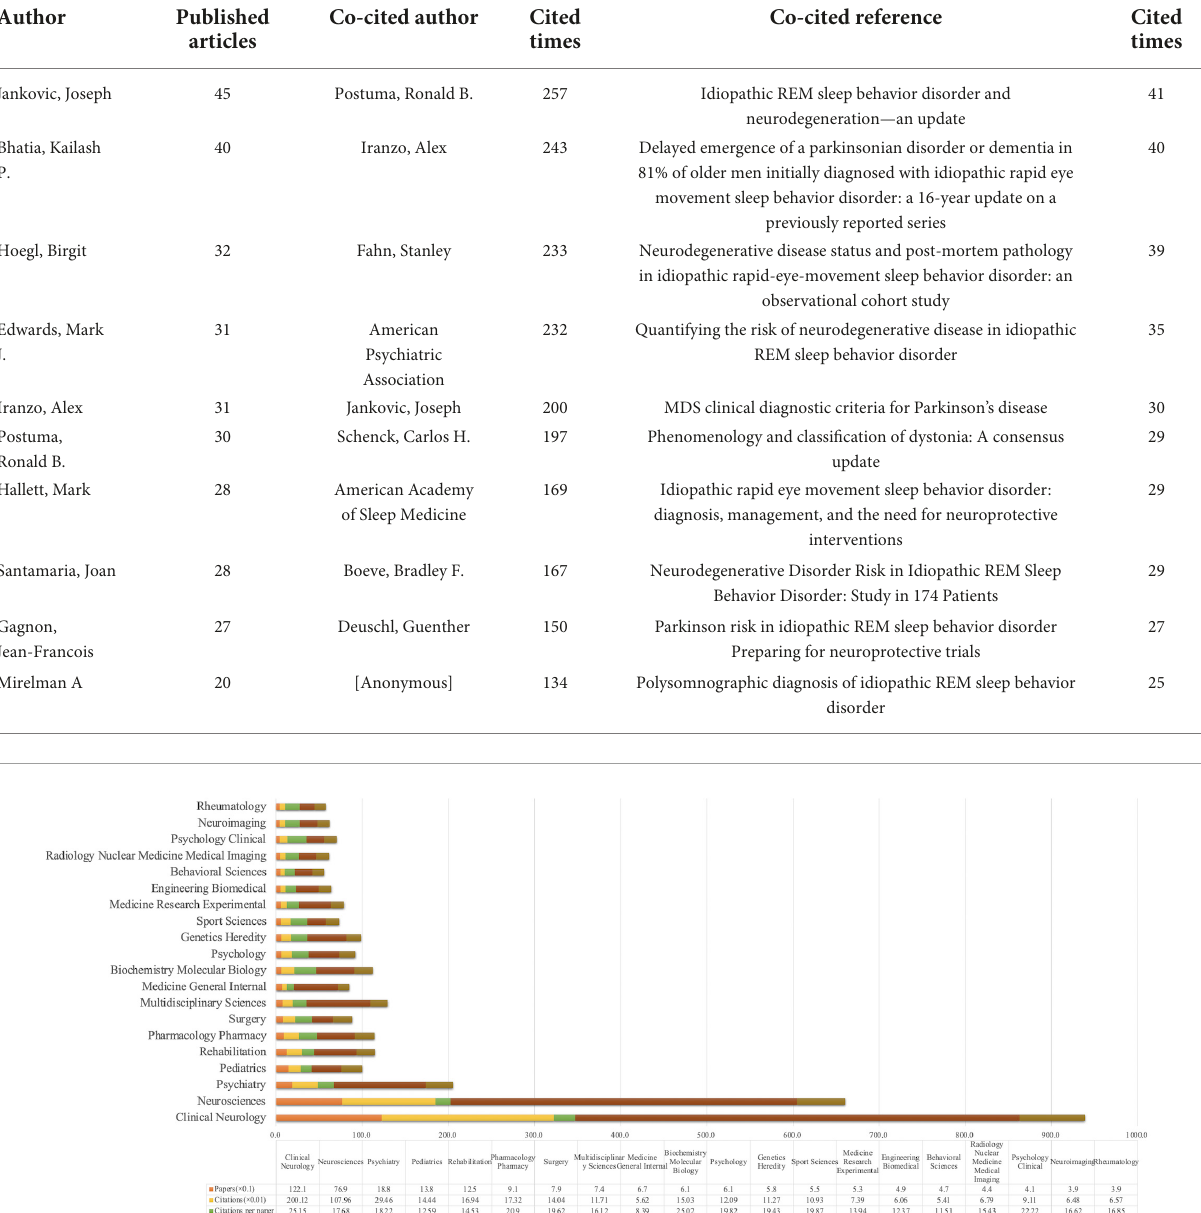
TABLE 2 The top 10 authors, co-cited authors, and co-cited references on exercise for movement disorders.